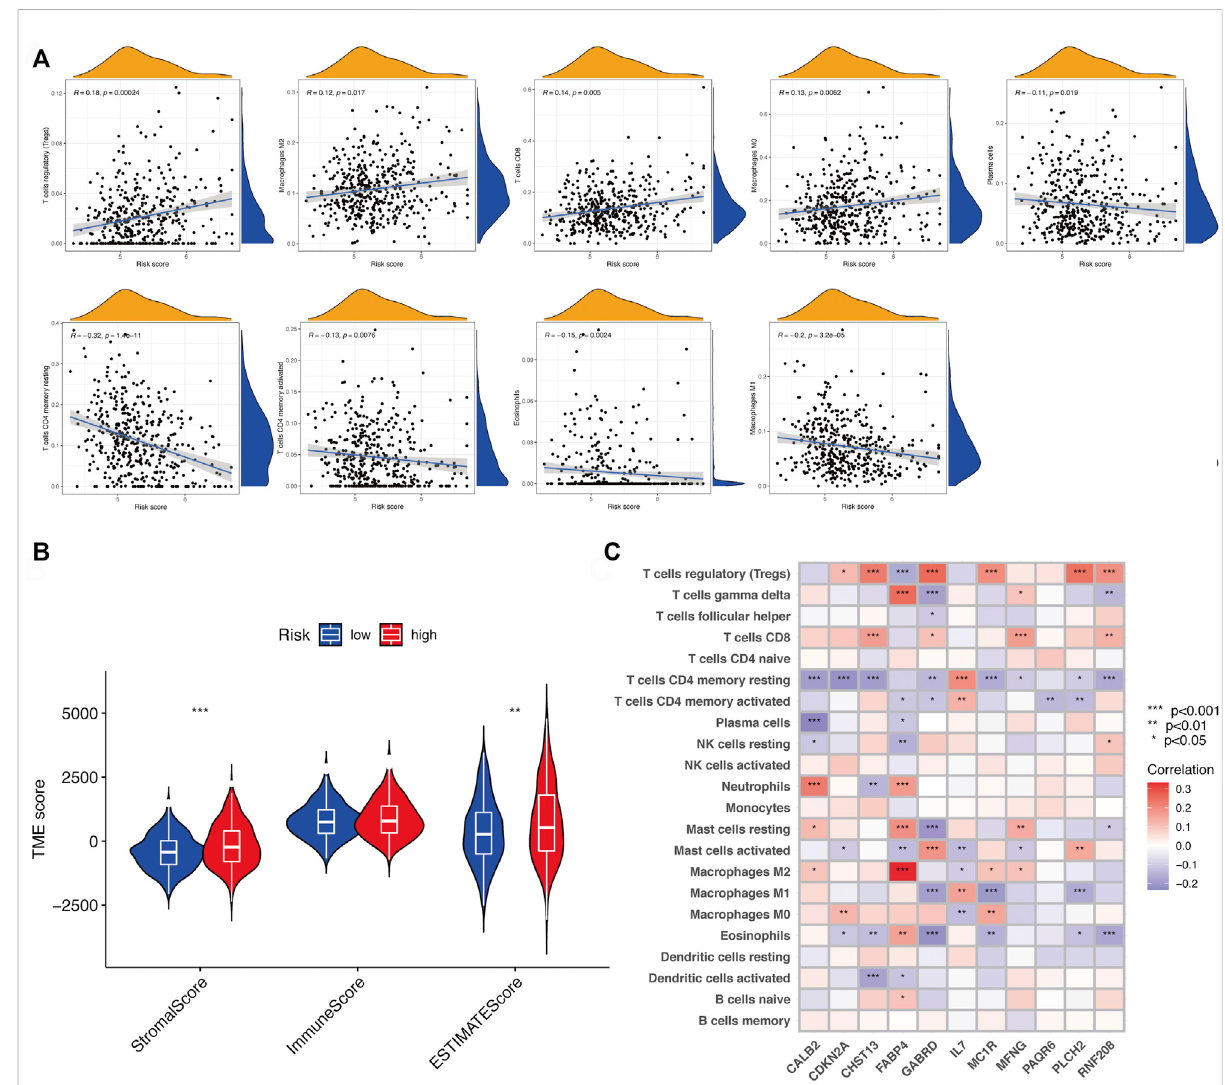
FIGURE 9 Assessment of TME between two risk subgroups. (A) Correlation of risk score and different types of immune cells. (B) Immune and stromal scoresintheriskgroups. (C) Correlation between 11genesand 22types ofimmune cells. ns, p > 0.05. ns,notsigni fi cant;*, p < 0.05;**, p < 0.01; ***, p <